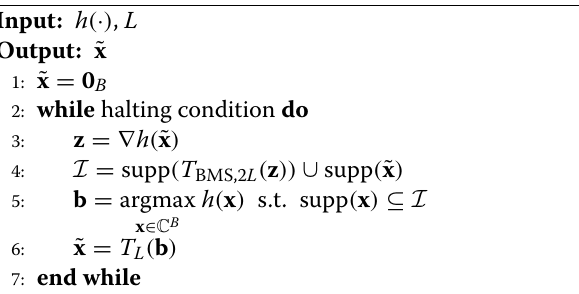
Algorithm 2 BMSGraSP algorithm